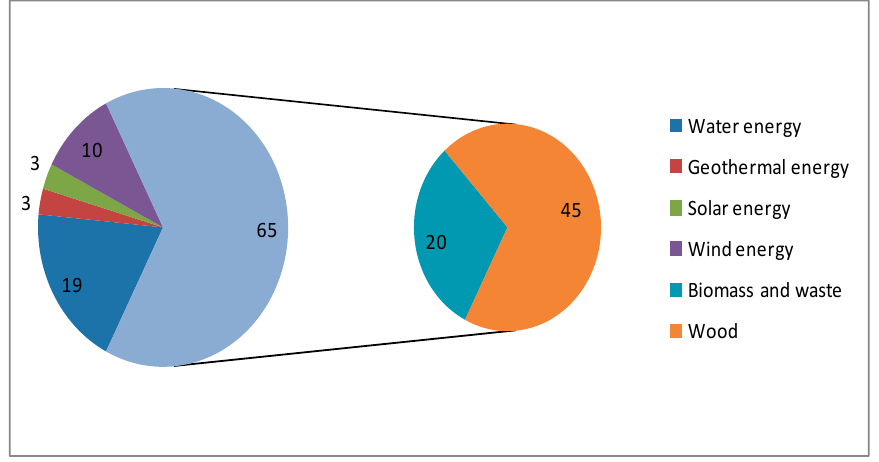
Figure 8. RES consumption for the EU-27 in 2019 (in terms of percentage) [55].